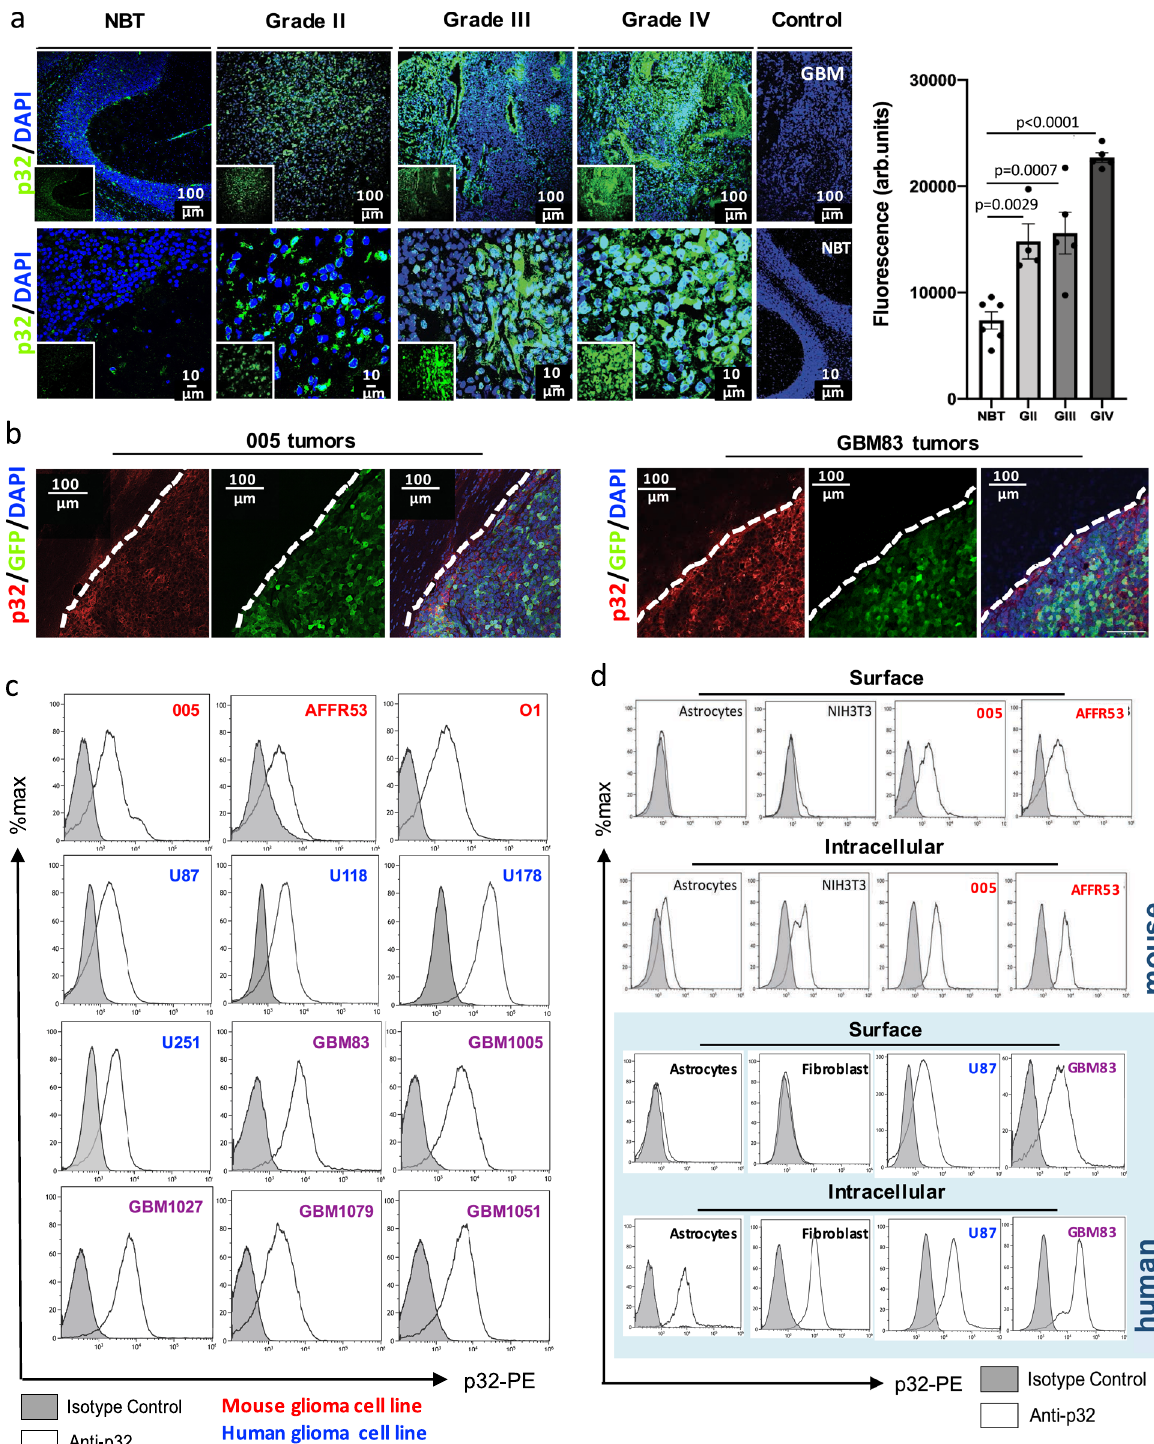
T cells (Fig. 2f, g), and no differences were observed in the expression of representative exhaustion markers (Fig. 2h, i), sug- gesting that the introduction of the CARs into T cells did not result in tonic signaling. Phenotypic analysis of human lymphocytes showed that p32 CAR + T cells contained central-memory, effector- memory, and T stem cell memory, without signi fi cant difference between untransduced and CAR + expressing